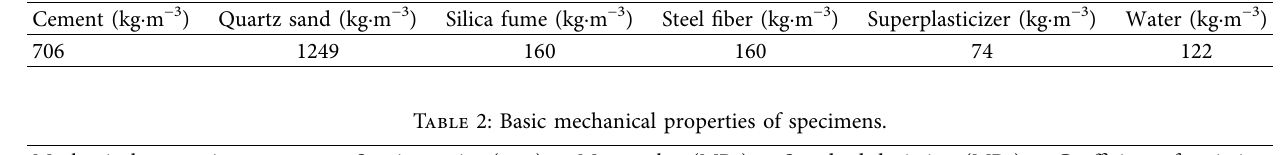
Table 1: Mixing proportion of raw